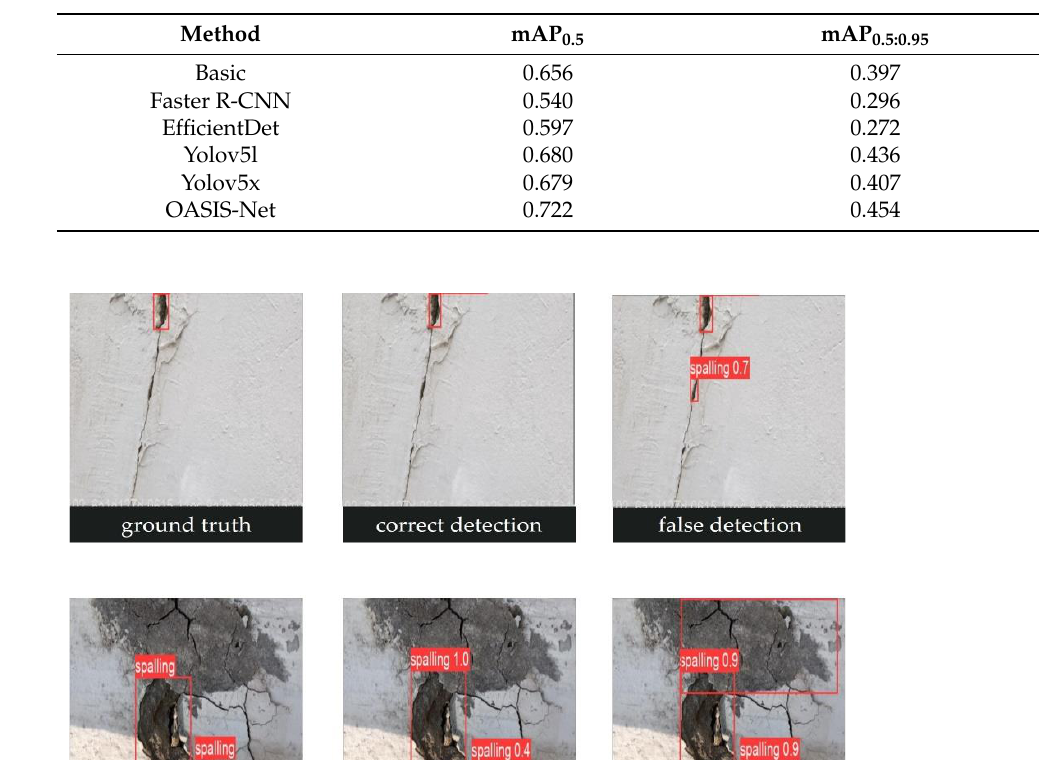
Table 3. Comparison of the mean average precision (mAP) of the spalling detection.